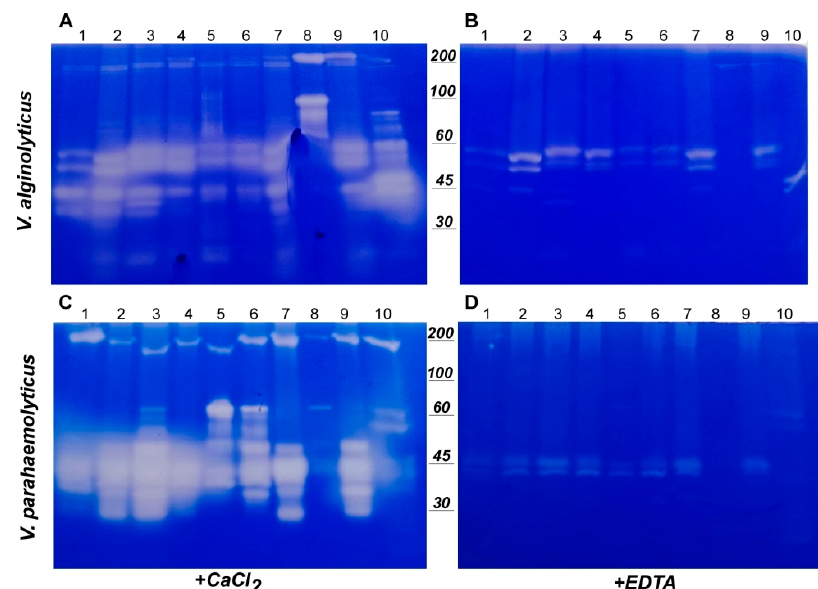
Figure 7. Zymographic analysis of gelatinase activity of secreted proteases. The gelatinolytic activity of supernatants from liquid cultures of V. alginolyticus ( A , B ) and V. parahaemolyticus ( C , D ) and was visualized by zymography, using gelatine as substrate. Gelatinolytic activity was measured either in presence of CaCl 2 ( A , C ) or EDTA ( B , D ). Culture media were as follows: MB 0.2 × (1); MB (2); MB + Gel (3); MB + AA (4); MB + YE (5); MB + Pept (6); MB + Glc (7); MB + Gly (8); MB + Fe (9); MB + ME (10).